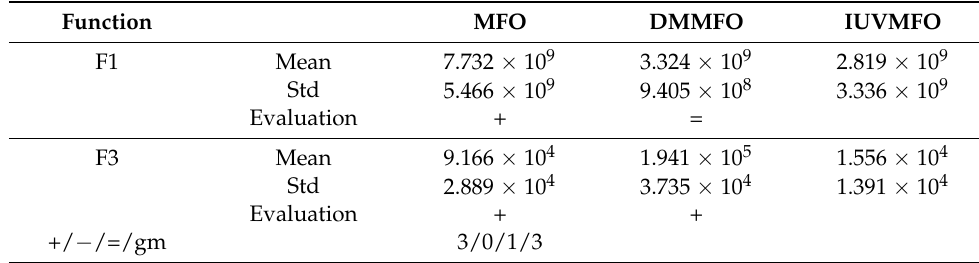
Table A3. Statistics of 50-dimensional Function Test